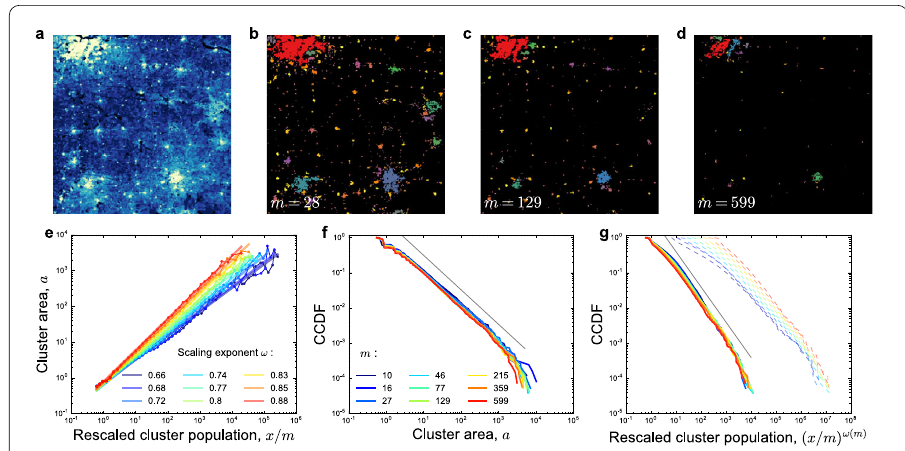
Figure 4 Scaling properties of urban clusters. ( a ), Portion of the GRUMP dataset representing the distribution of population in a region of the Midwestern United States. The color denotes the logarithm of the population: light yellow for high population, dark blue for low population. ( b )–( d ), Urban clusters in the region depicted in panel ( a ) obtained applying the City Clustering Algorithm for different values of the minimum population parameter: m = 28 in ( b ), 129 in ( c ), 599 in ( d ). ( e ), Scaling relationship between area and population of clusters. The different colors denote different values of the CCA parameter m (see the legend of panel ( f ) for the m values). The points indicate the average area of clusters with a given rescaled population. Data are fit to the power law in Equation (3) and the legend reports the values of the scaling exponent ω for the various m . ( f ), Counter Cumulative Distribution Functions of cluster areas. The different colors denote different values of the CCA parameter m (see the legend for the m values). The grey line is a power law with exponent –1 as a guide for the eye. ( g ), Counter Cumulative Distribution Functions of cluster populations, x (dashed curves), and rescaled populations, ( x / m ) ω ( m ) (solid curves). The grey line is a power law with exponent –1 as a guide for the